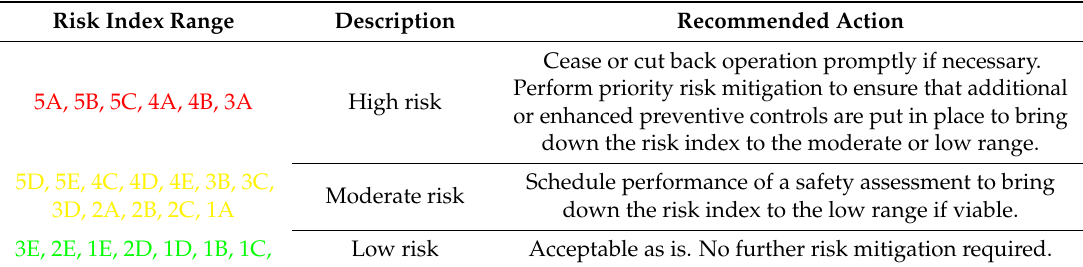
Table 6. Safety tolerability risk matrix [30].